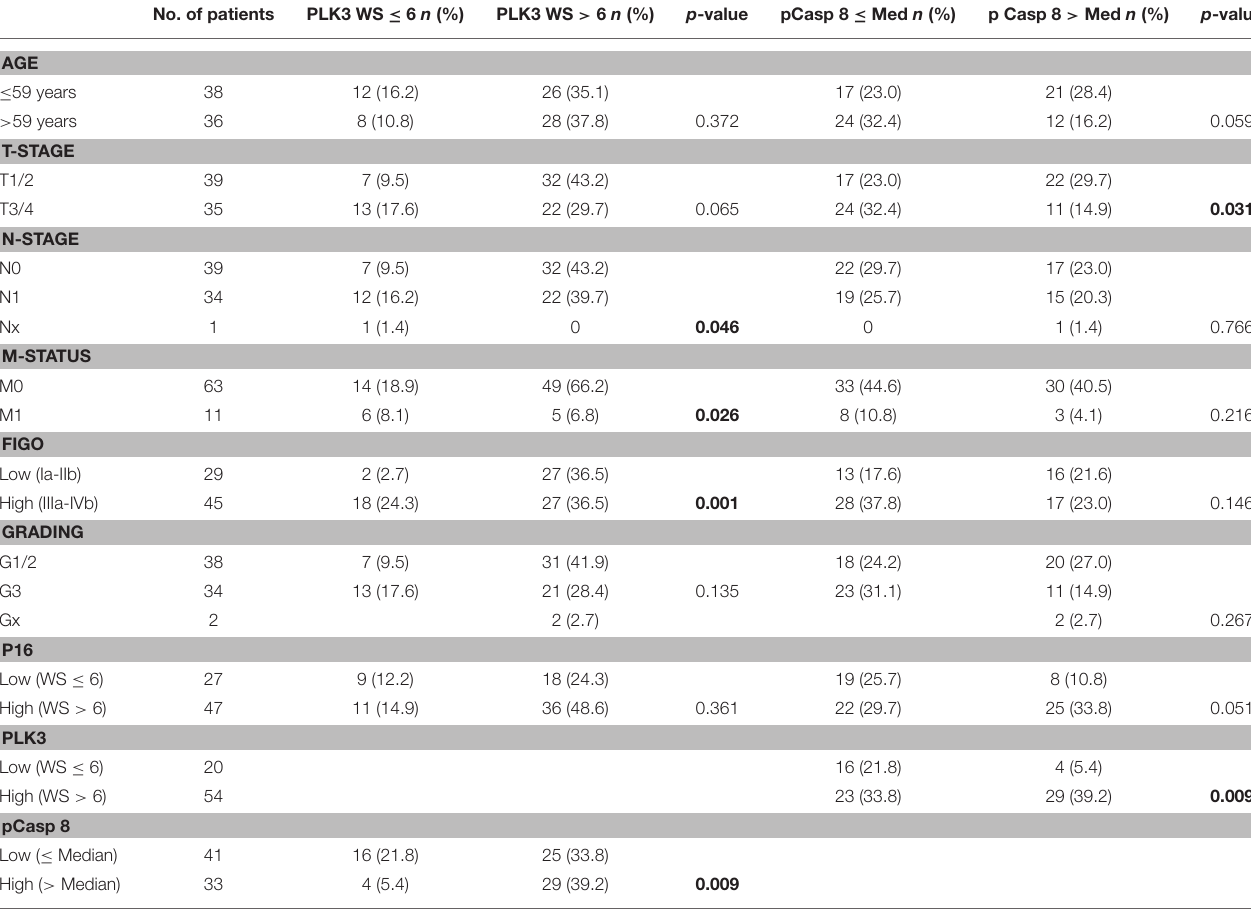
TABLE 2 | Clinicopathological findings according to PLK3 expression and T273 Caspase 8 phosphorylation. No. of